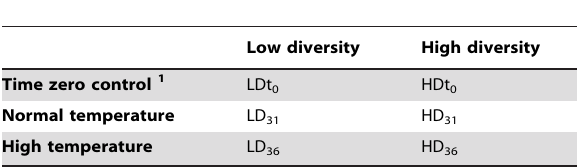
Table 1. Abbreviations for experimental